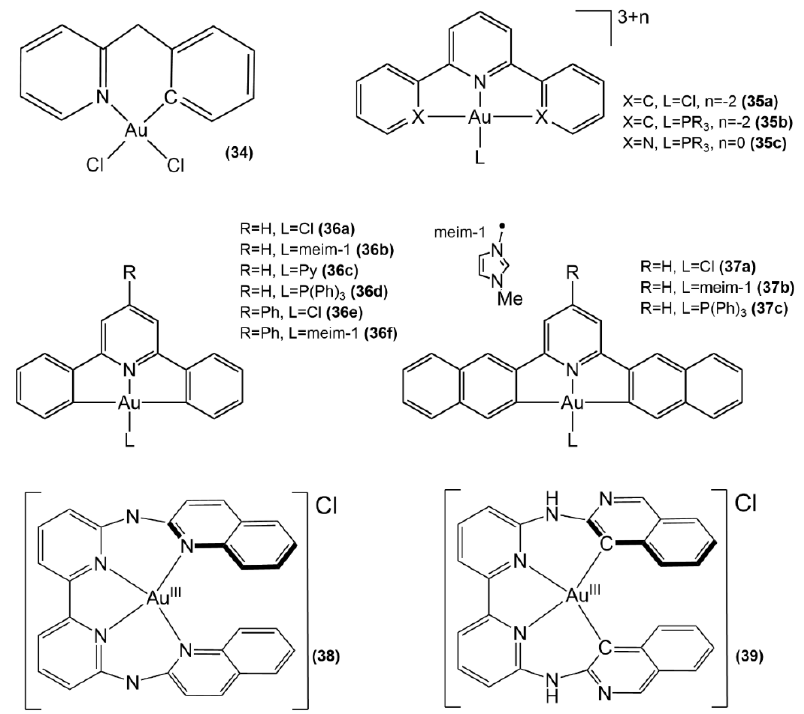
Figure 17. Au(III) complexes with benzylpyridine ( 34 ), diphenylpyridine ( 35a , 35b ), terpyridine ( 35c ), diphenylpyridine ( 36a – 36f ) and naphtalene-2-yl-pyridine ( 37a – 37c ), tetrapyridyl ( 38 , 39 ).